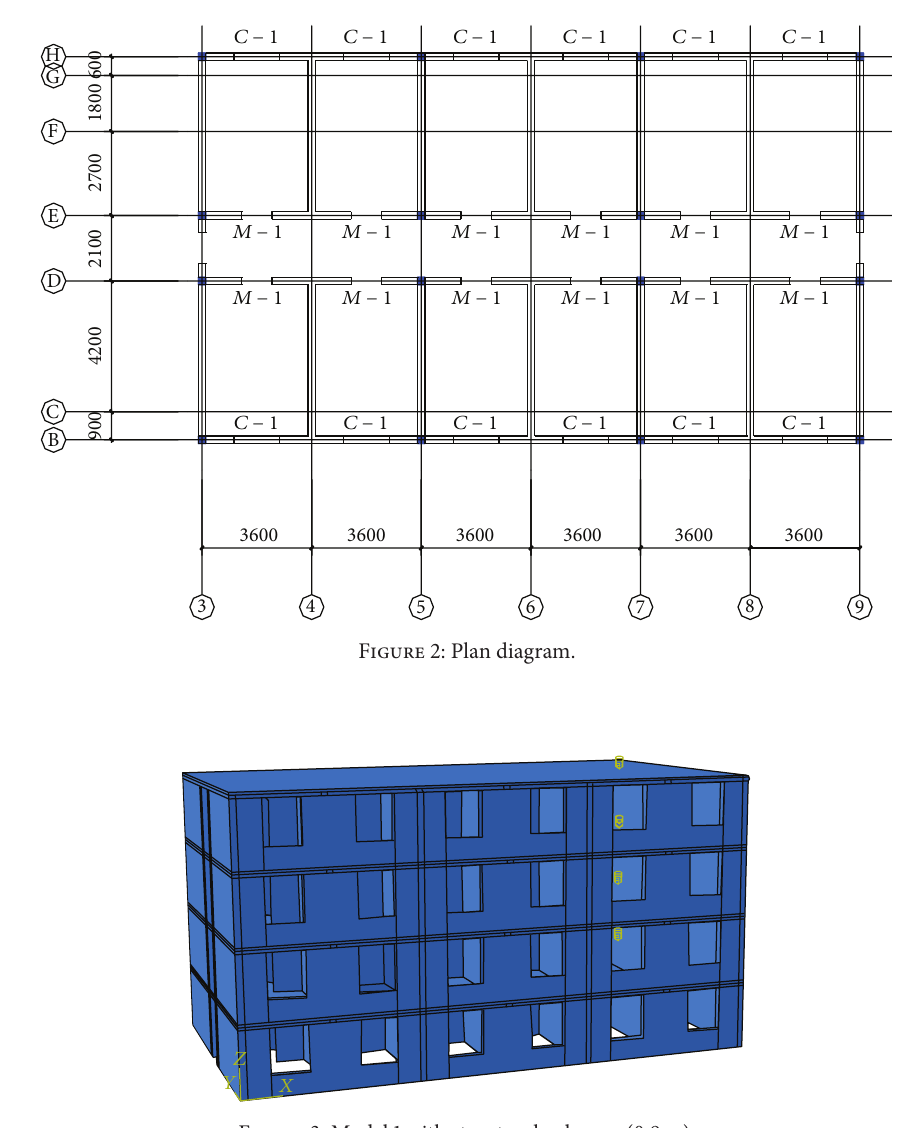
Figure 3: Model 1 with structural columns (0.9 m).